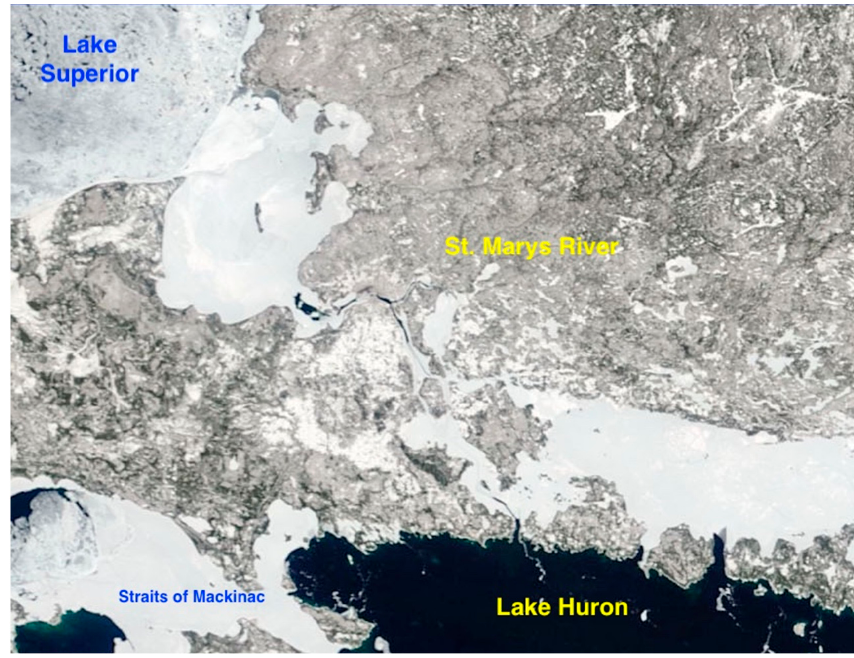
Figure 2. A zoomed-in view over the St. Marys River region from Figure 1. St. Marys River’s lati- tude N 46°30.079 ′ and longitude W 84°25.7424 ′ . Figure 2. Satellite image of the Great Lakes taken on 25 March 2019 based on the Moderate Resolution Imaging Spectroradiometer (MODIS) on NASA’s Terra satellite. Adapted from the NASA Earth Observatory website